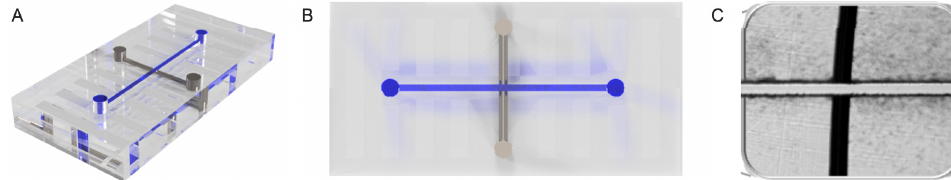
Figure 1. ( A ) Illustration of the microfluidic device with perpendicular fluidic microchannel and metal electrodes along with strain relief structures. ( B ) Simplified two-dimensional (2D) drawing highlighting microchannel-electrodes crossing pattern, and ( C ) microscope image showing the intersection of cylindrical 76 µ m diameter Pt electrodes and 50 µ m diameter microchannel for fluid